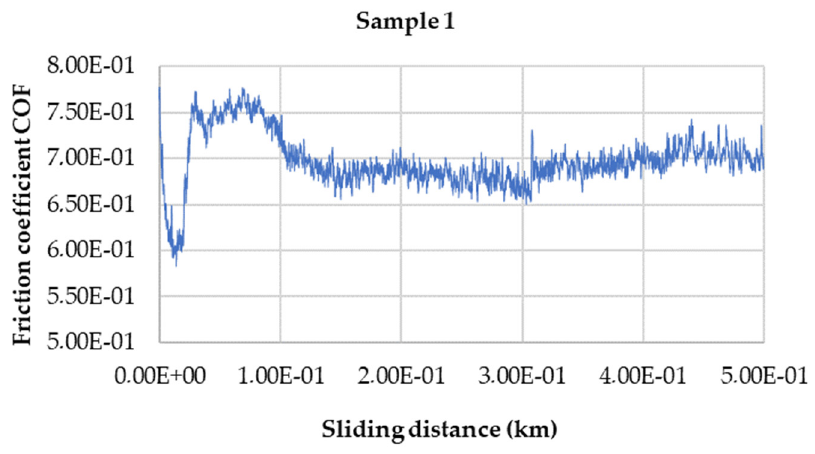
Figure 6. Course of COF for Ni-Co coatings (Sample 1) deposited at 1 A dm − 2 . The course of COF during the pin-on-disc test on Sample 2 at 400 ◦ C is shown in Figure 7. After an initial increase at the beginning of the test to a maximum value of